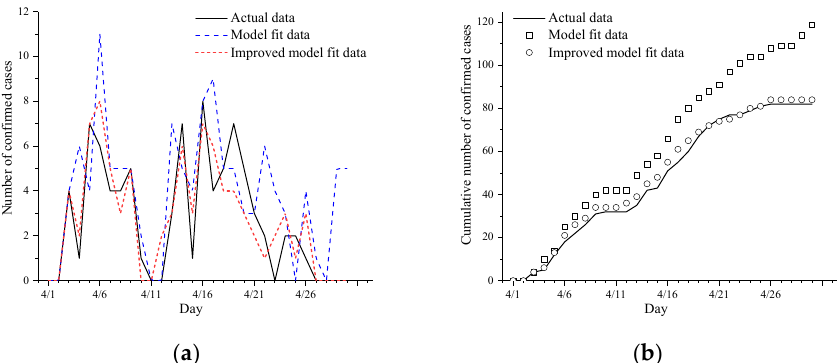
Figure 7. Model fitting results: ( a ) daily new confirmed fitting results for Taiyuan; ( b ) daily cumulative confirmed fitting results for Taiyuan.